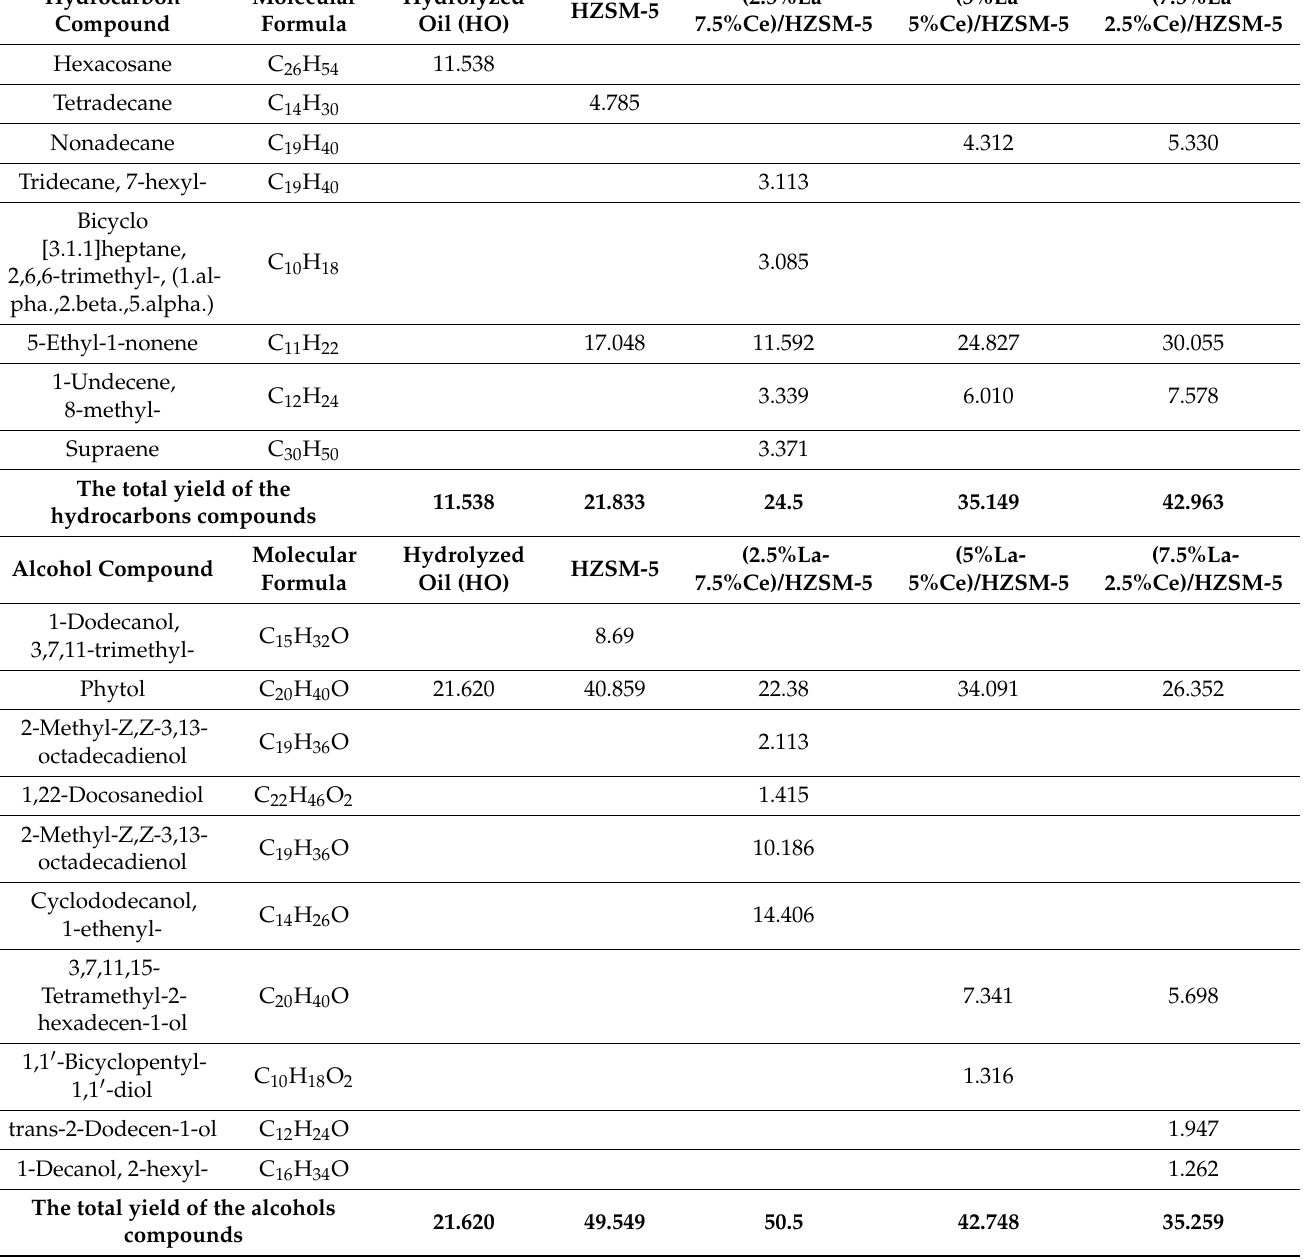
Table 6. Product yield percentages of outstanding hydrocarbon (alkanes and alkenes) and alcohol compounds from catalytic deoxygenation of the algal HO for the parent and Lanthanum-Cerium- modified zeolites at 300 ◦ C for 6 h under initial N 2 pressure of 7 bar, at 1000 rpm and with 23.6 g of algal HO/3.54 g of the catalyst in the batch